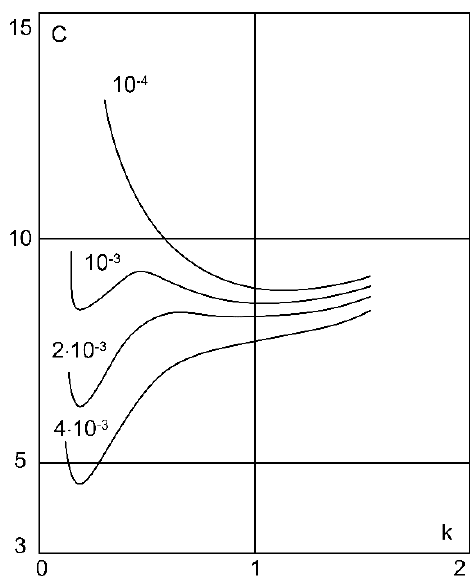
Figure 2. Neutral curves for h = 10 and different values of Da.